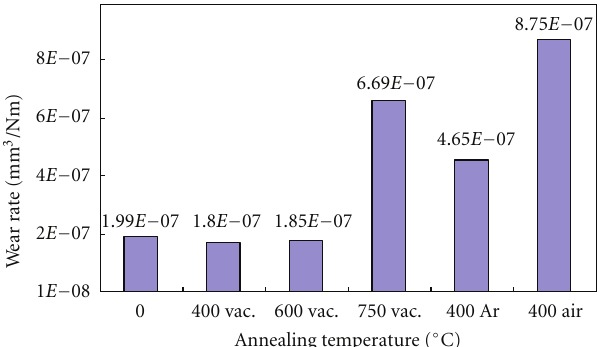
Figure 8: Specific wear rate of DLC-SiO films with 34 at.%Si before and after